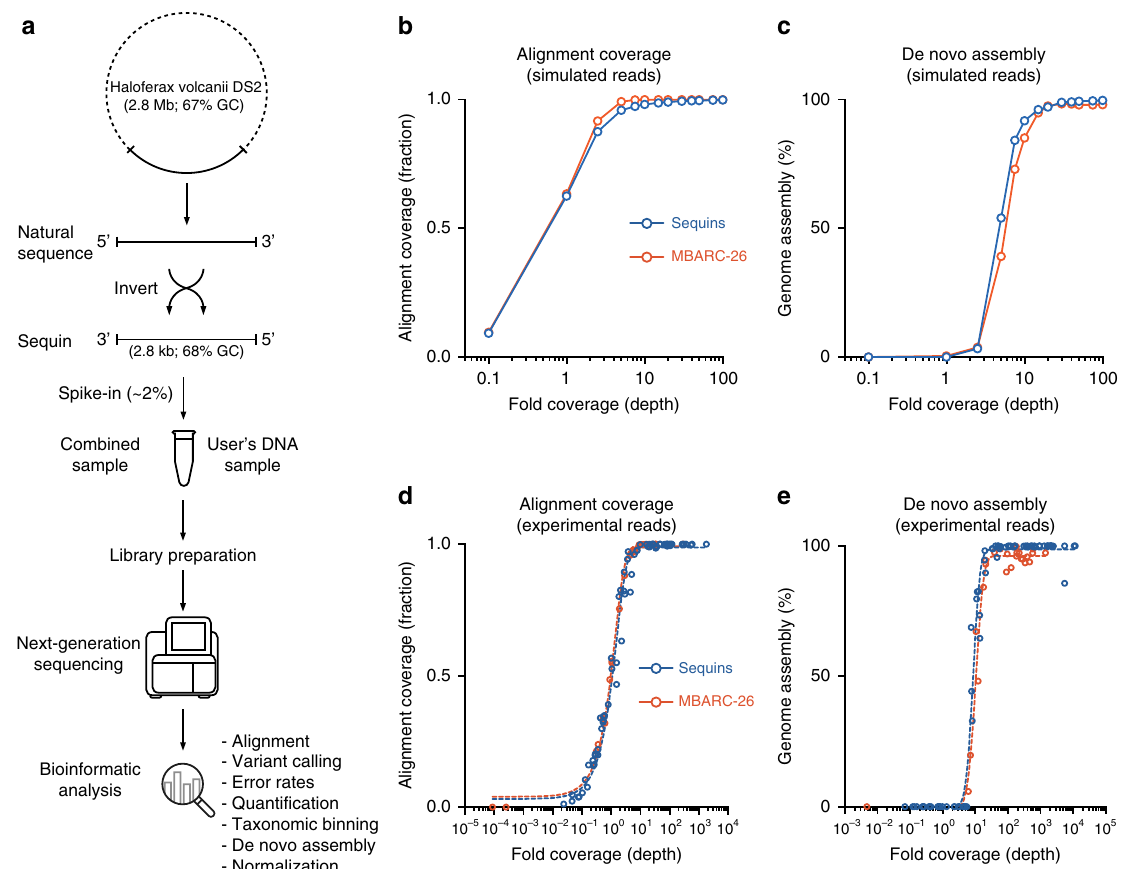
Fig. 1 Schematic showing the design, use, and validation of DNA-sequencing spike-ins (sequins) for metagenomic analysis. a Metagenome sequins are designed by inverting a selected subsequence of a microbial genome that is then synthesized and combined with other DNA standards into a staggered mixture which represents a natural microbial community. Sequins are spiked into a user ’ s DNA sample (at a low fractional concentration, e.g., 2%), undergoing combined library preparation, sequencing, and analysis. Examples of the bioinformatic steps that can be assessed using sequins are indicated. To validate the design of sequins, we generated simulated libraries that were not confounded by additional technical variables ( b , c ) and spiked sequins into a mock microbial community (MBARC-26) and sequenced the combined sample ( d , e ). Sequins (blue) displayed comparable breadth of alignment coverage to real microbial genomes (red) across the full range of fold-coverage depths observed in both simulated ( b ) and experimental ( d ) data. We also observed equivalent de novo assembly of sequins and MBARC-26 genomes at matched fold-coverage levels in both simulated ( c ) and experimental ( e ) data. The dashed lines in d and e were fi tted using Richard ’ s fi ve-parameter dose – response